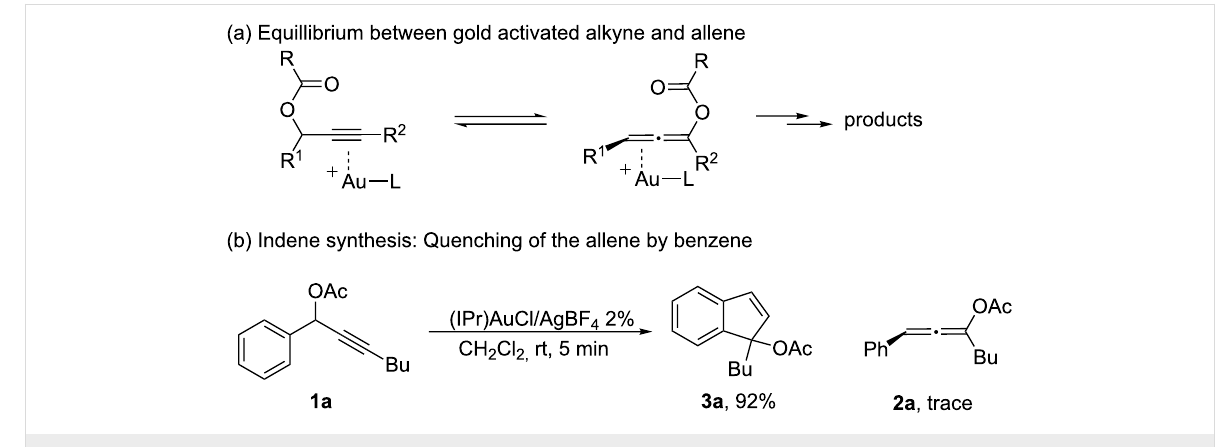
Scheme 2: The challenge of the synthesis of allenes through gold activated